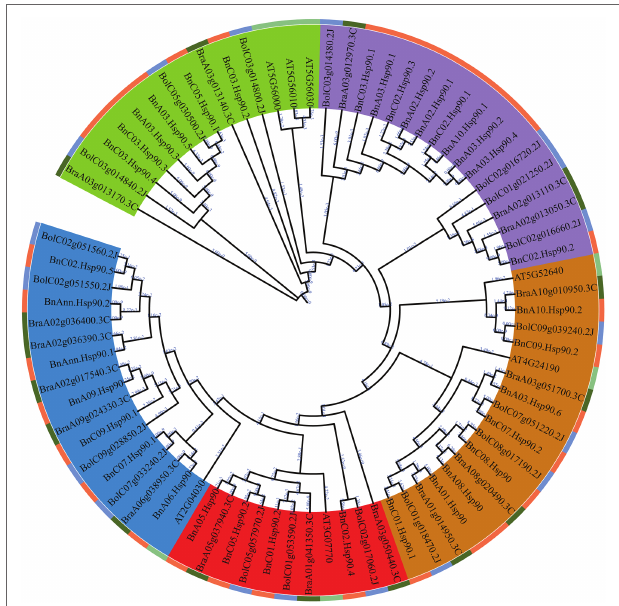
FIGURE 1 | Phylogenetic tree of Hsp90 proteins from A. thaliana , B. rapa , B. oleracea , and B. napus . The Hsp90s were divided into five groups (groups I–V) based on the clustering of the protein sequence. The proteins from A. thaliana , B. rape , B. oleracea and B. napus are presented in light green, blue, dark green, and orange, respectively. The IDs of proteins from Brassica napus , Brassica rapa , Brassica oleracea , and Arabidopsis thaliana start with Bn, Bra, Bol, and AT, respectively. Branch length is indicated on each